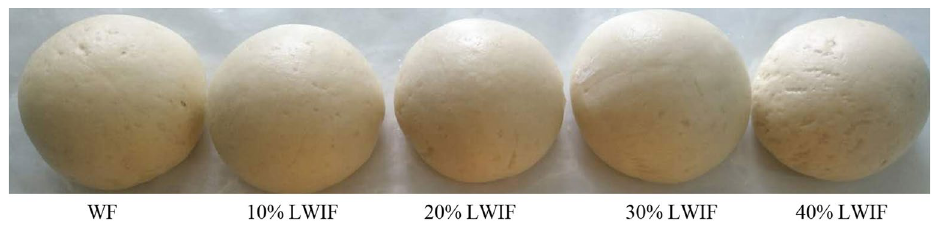
Figure 2. Steamed bread prepared from WF and LWIF of different substitution